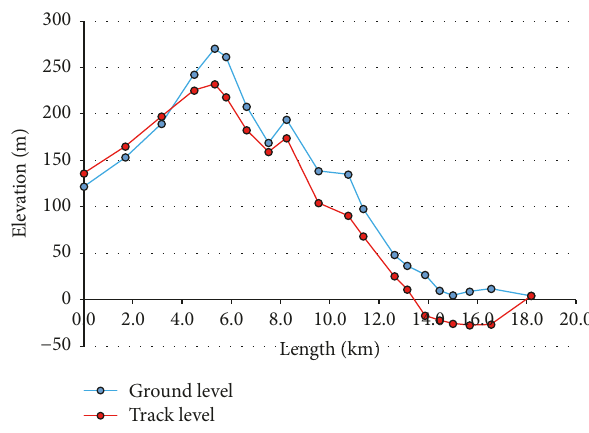
Figure 4: Elevation profile of Line 1 (from Piscinola to Garibaldi).